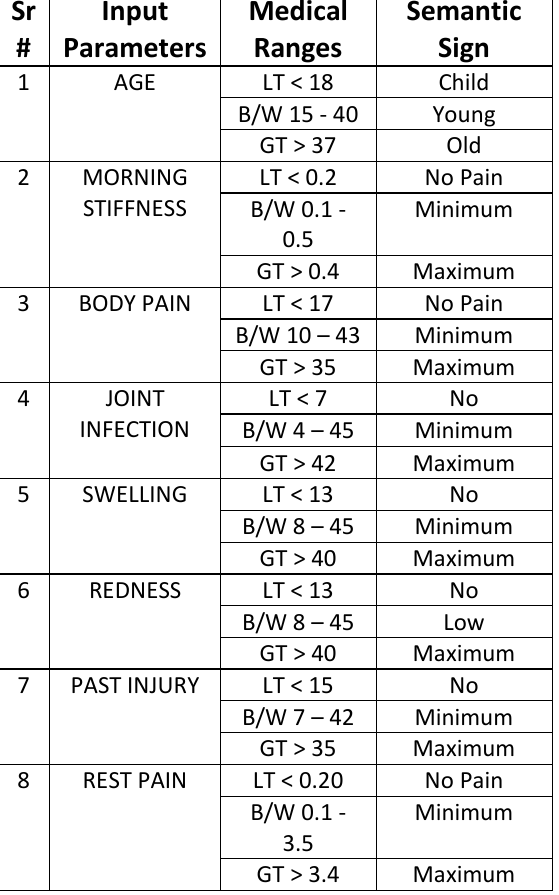
Table 2. Layer-II input variables with medical ranges of proposed DA-AH-MFES expert system